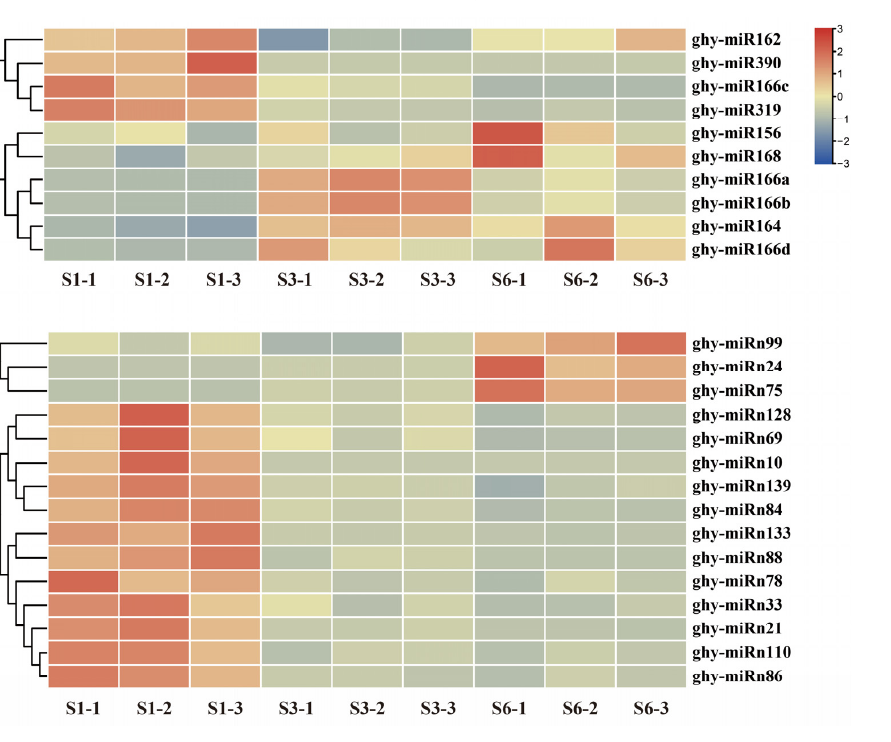
Figure 5. Heat map of differentially expressed miRNAs in gerbera. The miRNAs were clustered by hierarchical clustering according to their expression patterns during growth of ray florets. The expression levels are marked by color with red indicating upregulation and blue indicating downregulation.